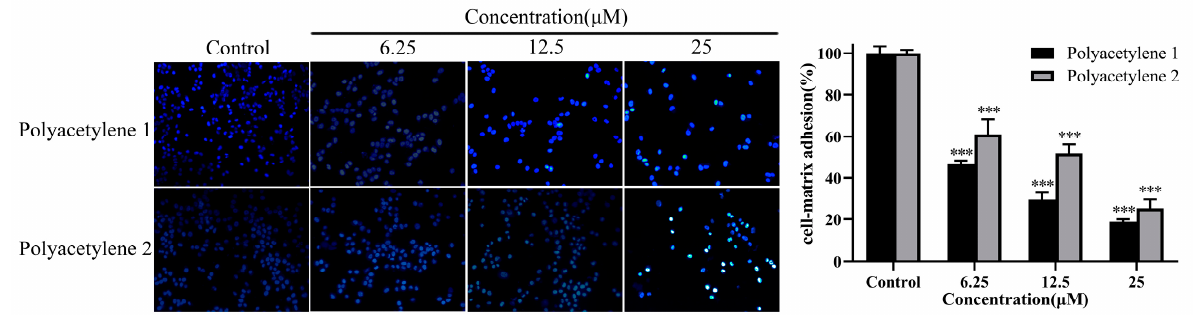
Figure 5. Effects of polyacetylenes 1 and 2 on the cell adhesion matrix capability of HGC-27 cells. Cells were treated with 25, 12.5, and 6.25 µM of polyacetylenes 1 and 2 for 24 h. The results are shown at 100× magnification. Compared with the control group, polyacetylenes 1 and 2 inhibited the wound-healing ability of HGC-27 in a dose-dependent manner, in which the inhibition ability of polyacetylene 1 was more significant. Significant differences compared with the control group are designated as *** p < 0.001. Results are expressed as the mean ± SEM (n = 3).